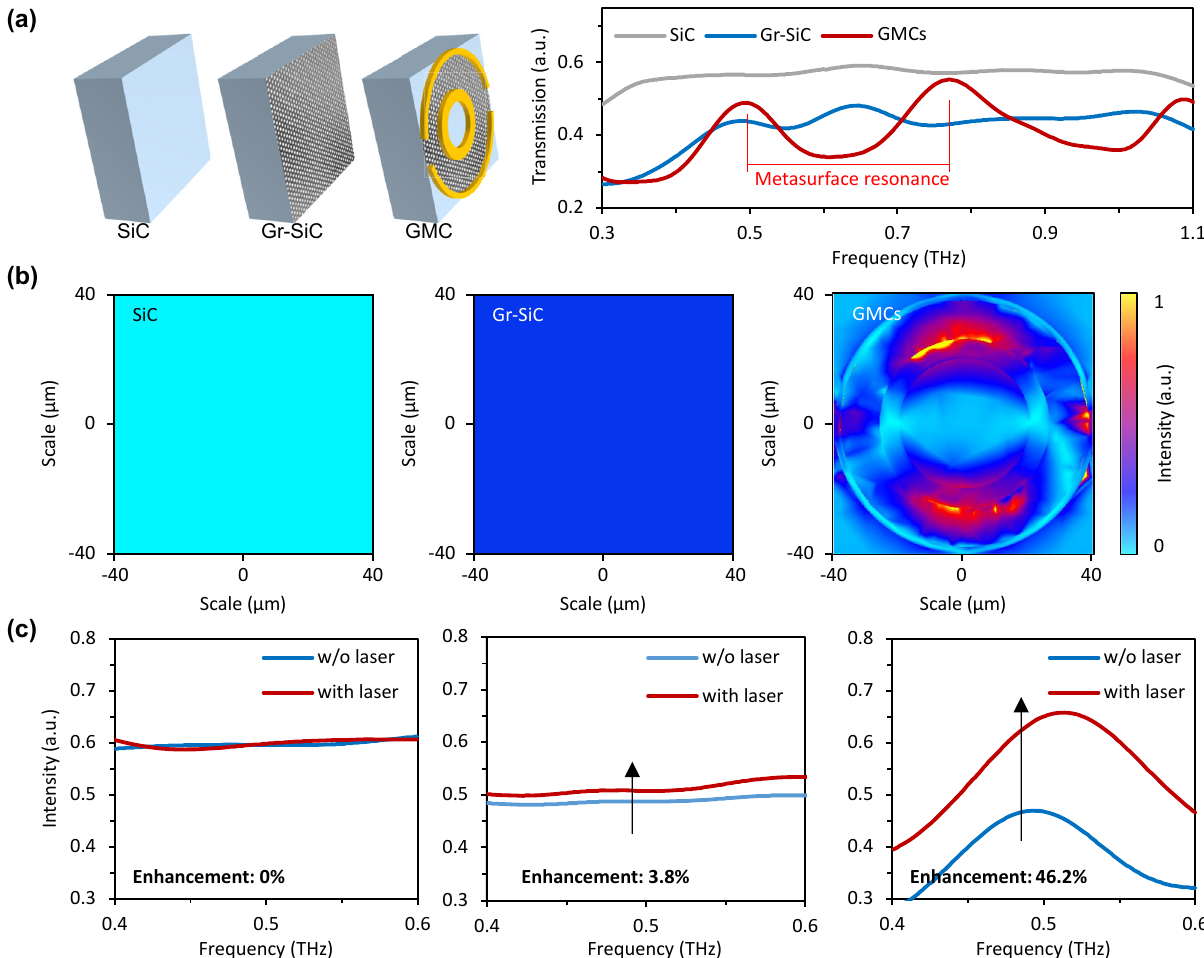
Figure 2: Observation of the dramatic terahertz boost. (a) Via designing the geometry of the metasurface superstructure, we enable terahertz resonance, with Q factor ≈ 10. Under strong excitation, it gathers higher energy at 0.5, 0.8, and 1.1 THz. (b) Simulated electrical field distributions of a terahertz wave (0.5 THz). The field intensity in the GMCs is much stronger than in ordinary SiC or Gr-SiC, providing conditions for optical nonlinear regulation. Color bar: Normalized THz intensity. (c) Measured optical tuning. After 300 mW laser irradiation, terahertz transmission of the GMCs increases from 0.45 au–0.658 au, approaching 46.2% enhancement at the frequency 0.5 THz. Here the minor resonance shift is induced by thermal